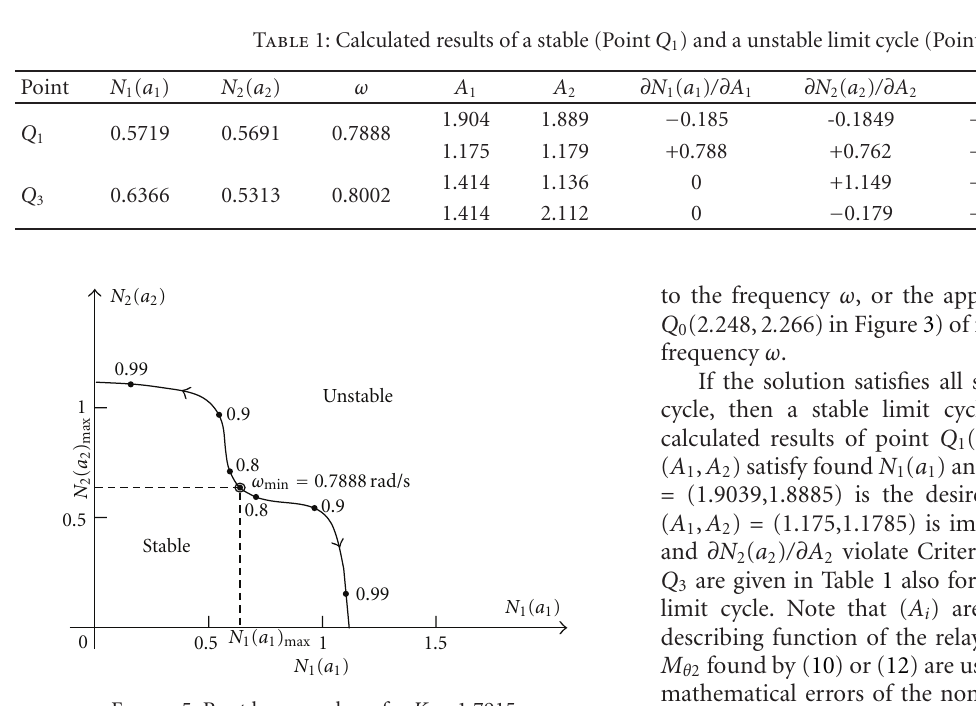
Figure 5: Root locus analyses for K = 1 . 7915.